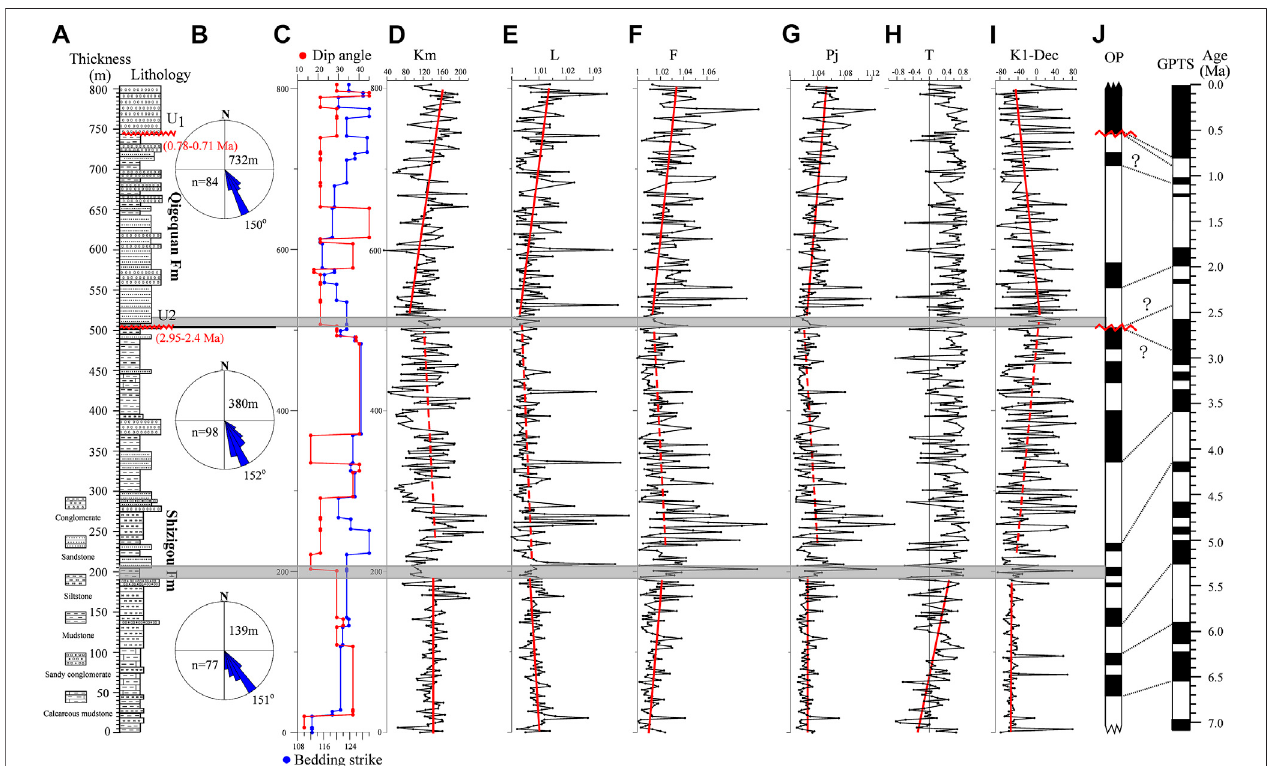
FIGURE 2 | Lithostratigraphy (A) , restored paleocurrent directions (B) , bedding strike and dip (C) , AMS parameters (magnetic susceptibility (Km), lineation (L), foliation (F), corrected degree of anisotropy (Pj), shape parameter (T) and declination of K 1 in tilt corrected coordinates) (D – I) and polarity correlations with the geomagnetic polarity time scale (J) plotted against depth in the Qigequan pro fi le (Zhang et al., 2013).